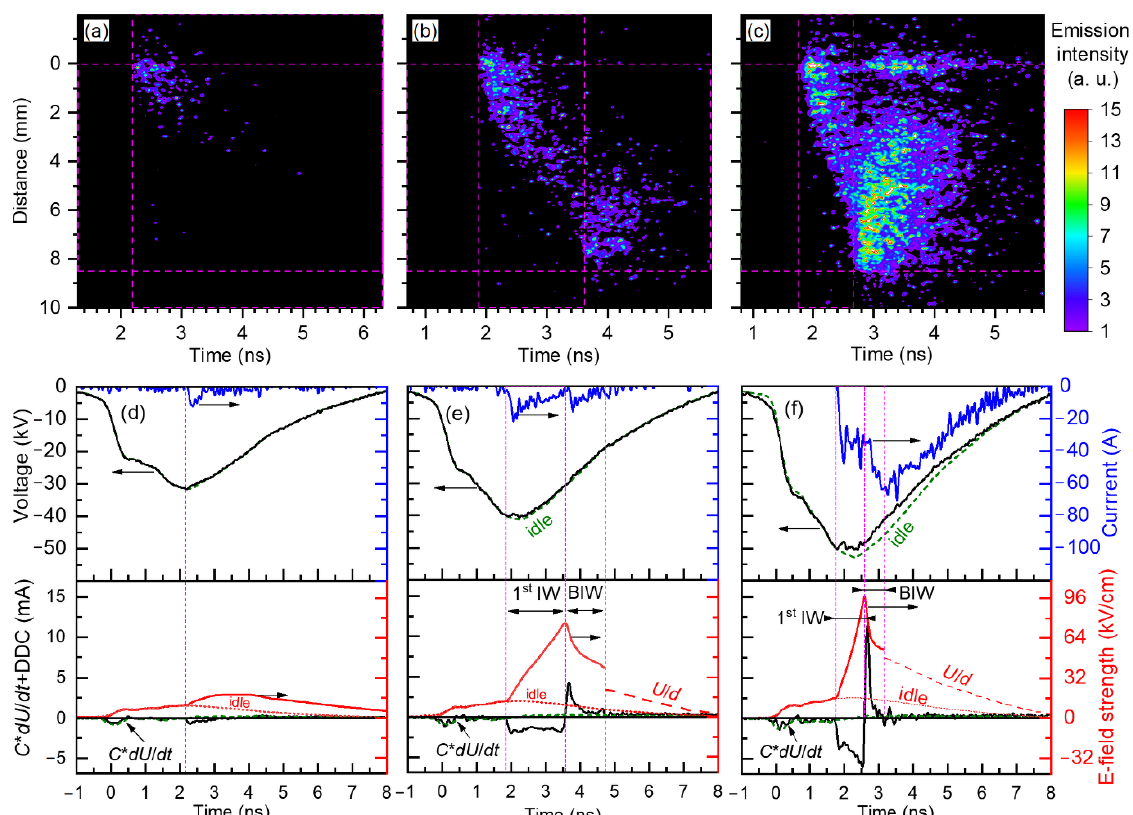
Figure 4. ( a – c ) Streak-images of the discharge formation dynamics and ( d – f ) corresponding waveforms of voltage, U gap , current, I d , displacement current ( C gap dU gap / dt + DDC) measured with the collector placed downstream the grounded grid electrode, and the electric field strength (calculated) near the surface of the grounded electrode at various voltages across the gap. 1st IW — first ionization wave (streamer), BIW — backward ionization wave. Air at a pressure of 200 kPa.